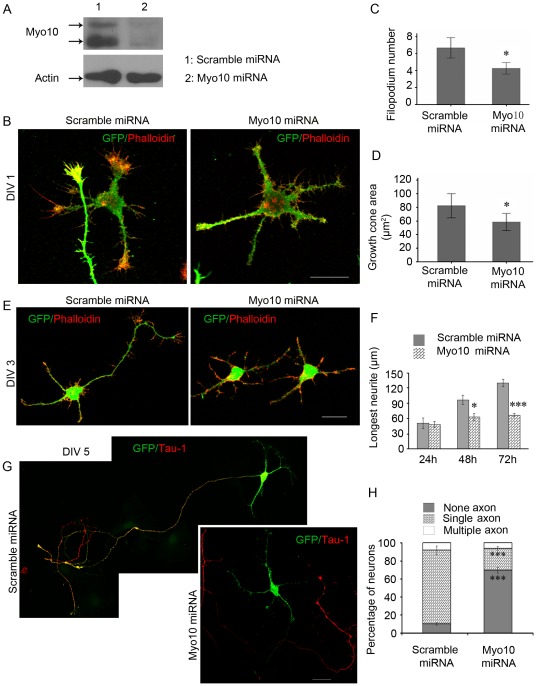
Loss of Myo10 function inhibits the formation of axon.A, Westen blot showing the down-regulation of Myo10 by Myo10 miRNA in cultured rat hippocampal neurons. B, Neurons transfected with scramble miRNA or Myo10 miRNA were stained with TRITIC-Pholloidin at DIV 1. C and D, Quantitative analysis of filopodium number and area of growth cone. E, Myo10 miRNA decreases the length of axon-like neurites at DIV 3. F, Quantitative analysis of the average length of the longest neurites 24, 48 and 72 h after plating. G, The neurons were stained with anti-Tau-1 antibody to identify axon at DIV 5. H, Percentages of neurons with none, single and multiple axons. Scale bar, 20 µm. *P<0.05; ***P<0.001.